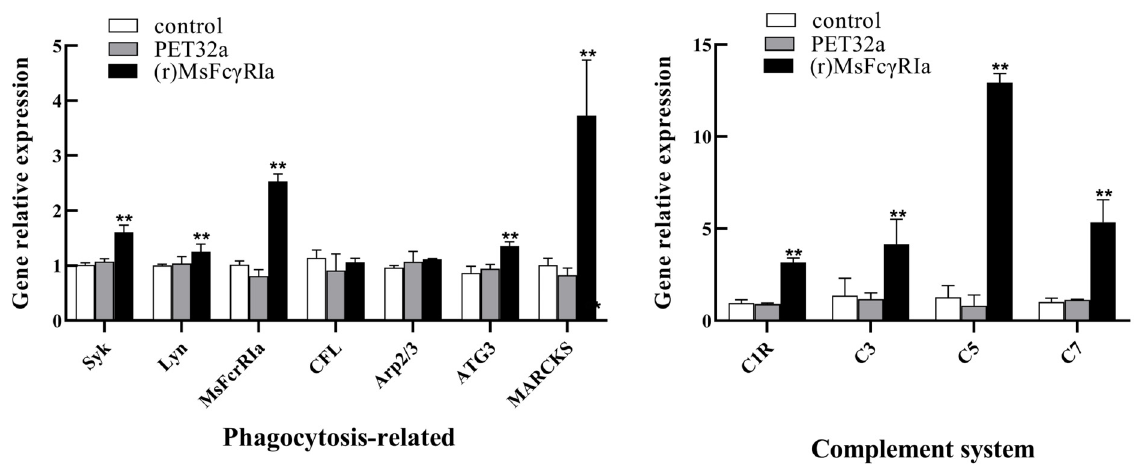
Figure 10. Analysis of gene expression in the leukocIs stimulated with (r)MsFc γ RI α . The relative mRNA expression level of several genes related to phagocytosis ( Syk , Lyn , Fc γ RI α , CFL , Arp2/3 , ATG3 , MARCKS ) and complement system ( C1R , C3 , C5 , C7 ) in leukocytes after recombinant MsFc γ RI α (5 µ g/mL) incubation were determined by qRT-PCR. Three biological replicates were performed, and the data are presented as mean ± SD ( n = 3). p > 0.05, not significant; p < 0.05; p < 0.01 (**), extremely significant.